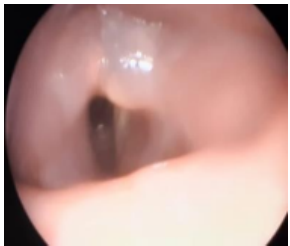
Figure 10. Chronic laryngitis due to GERD